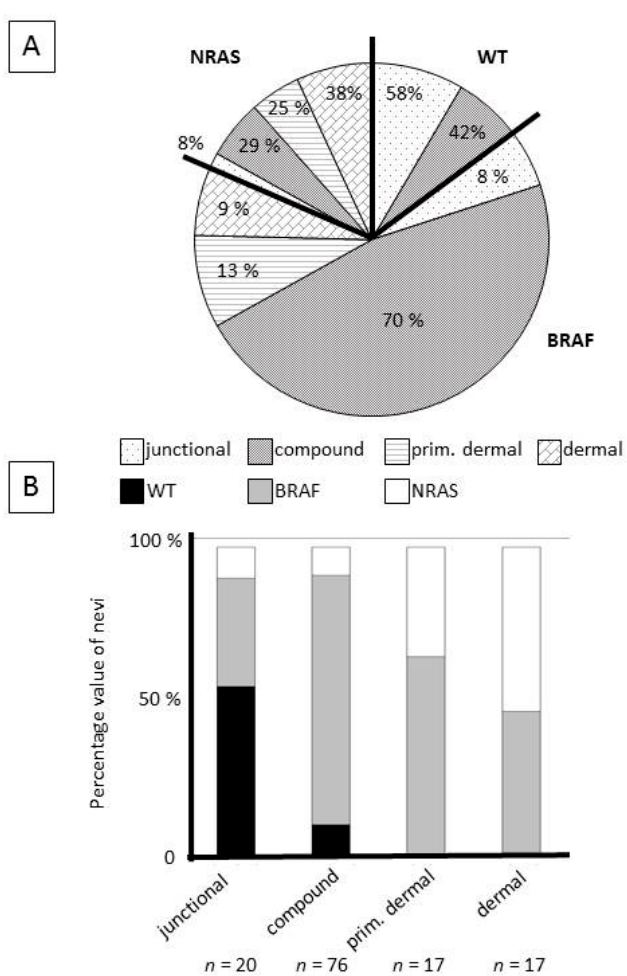
Figure 3. Associations of histological type and oncogene mutation status of naevi. ( A ) Percentage value of di ff erent histological naevus types in wild-type (WT), BRAF -, and NRAS -mutant cohorts. ( B ) Percentage value of wild-type (WT), BRAF -, and NRAS -mutant naevi in the four di ff erent naevus locations (junctional, compound, primarily dermal, and dermal).